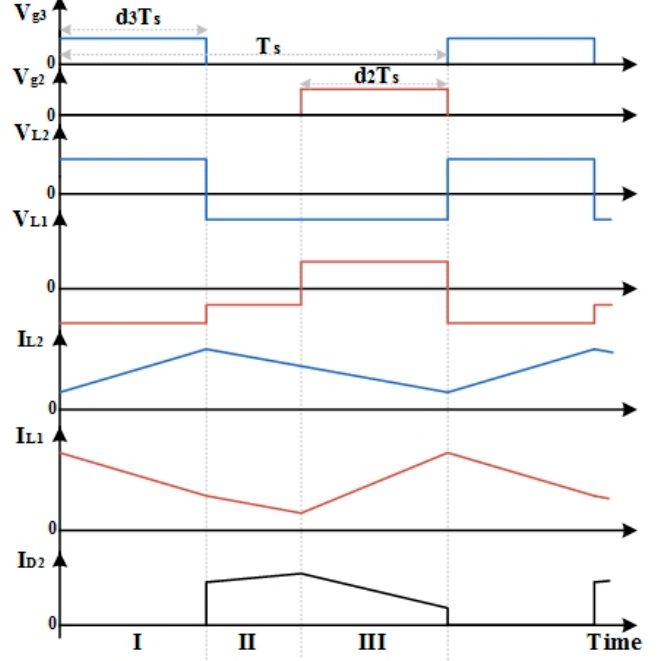
Figure 5. Typical waveforms for single input double output mode for continuous conduction mode.